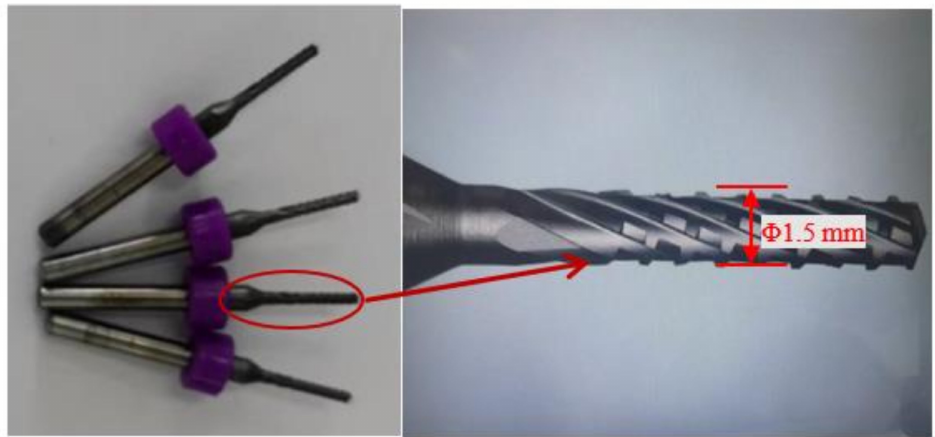
Figure 1. Milling tool used in the test.